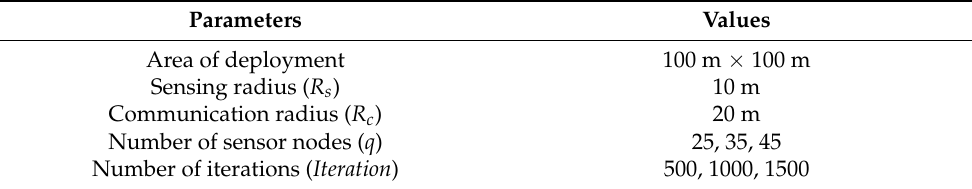
Table 9. Experimental parameter settings for the node deployment area.